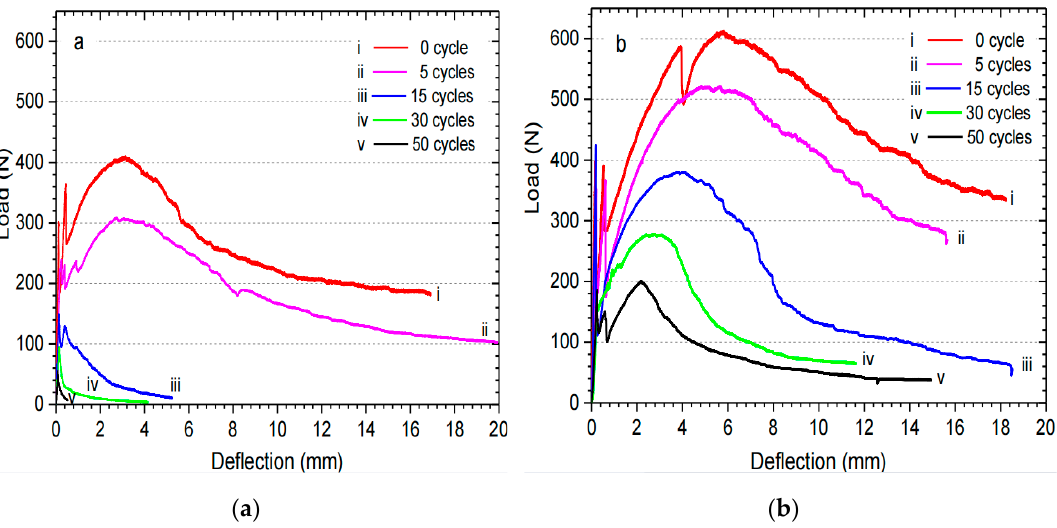
Figure 8. Typical load–deflection curves under wetting and drying cycles. ( a ) Cement slurry; ( b ) Geopolymer [82].